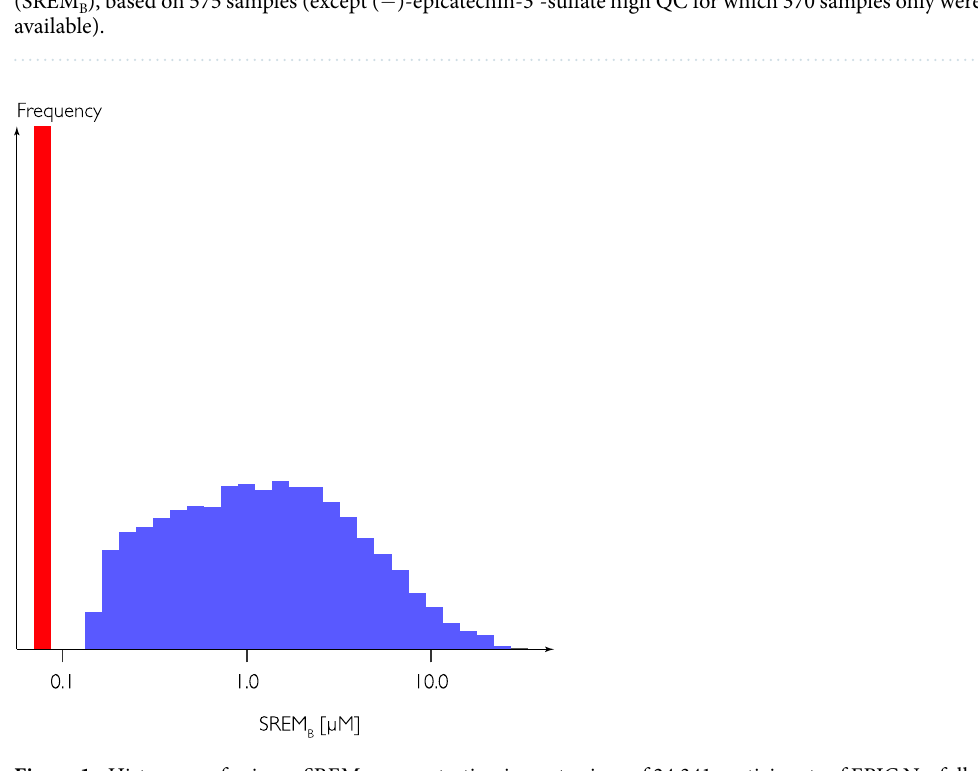
Table 3. Long term precision (%CV) and accuracy (%RE, difference of mean calculated concentration and nominal concentration, standardized by nominal concentration) data for the three SREMs used as biomarker